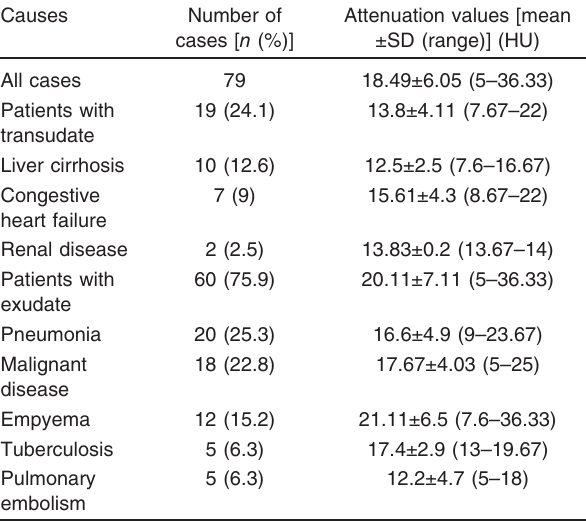
Table 2 Causes of pleural effusion and their computed tomography-attenuation values among the studied patients Causes